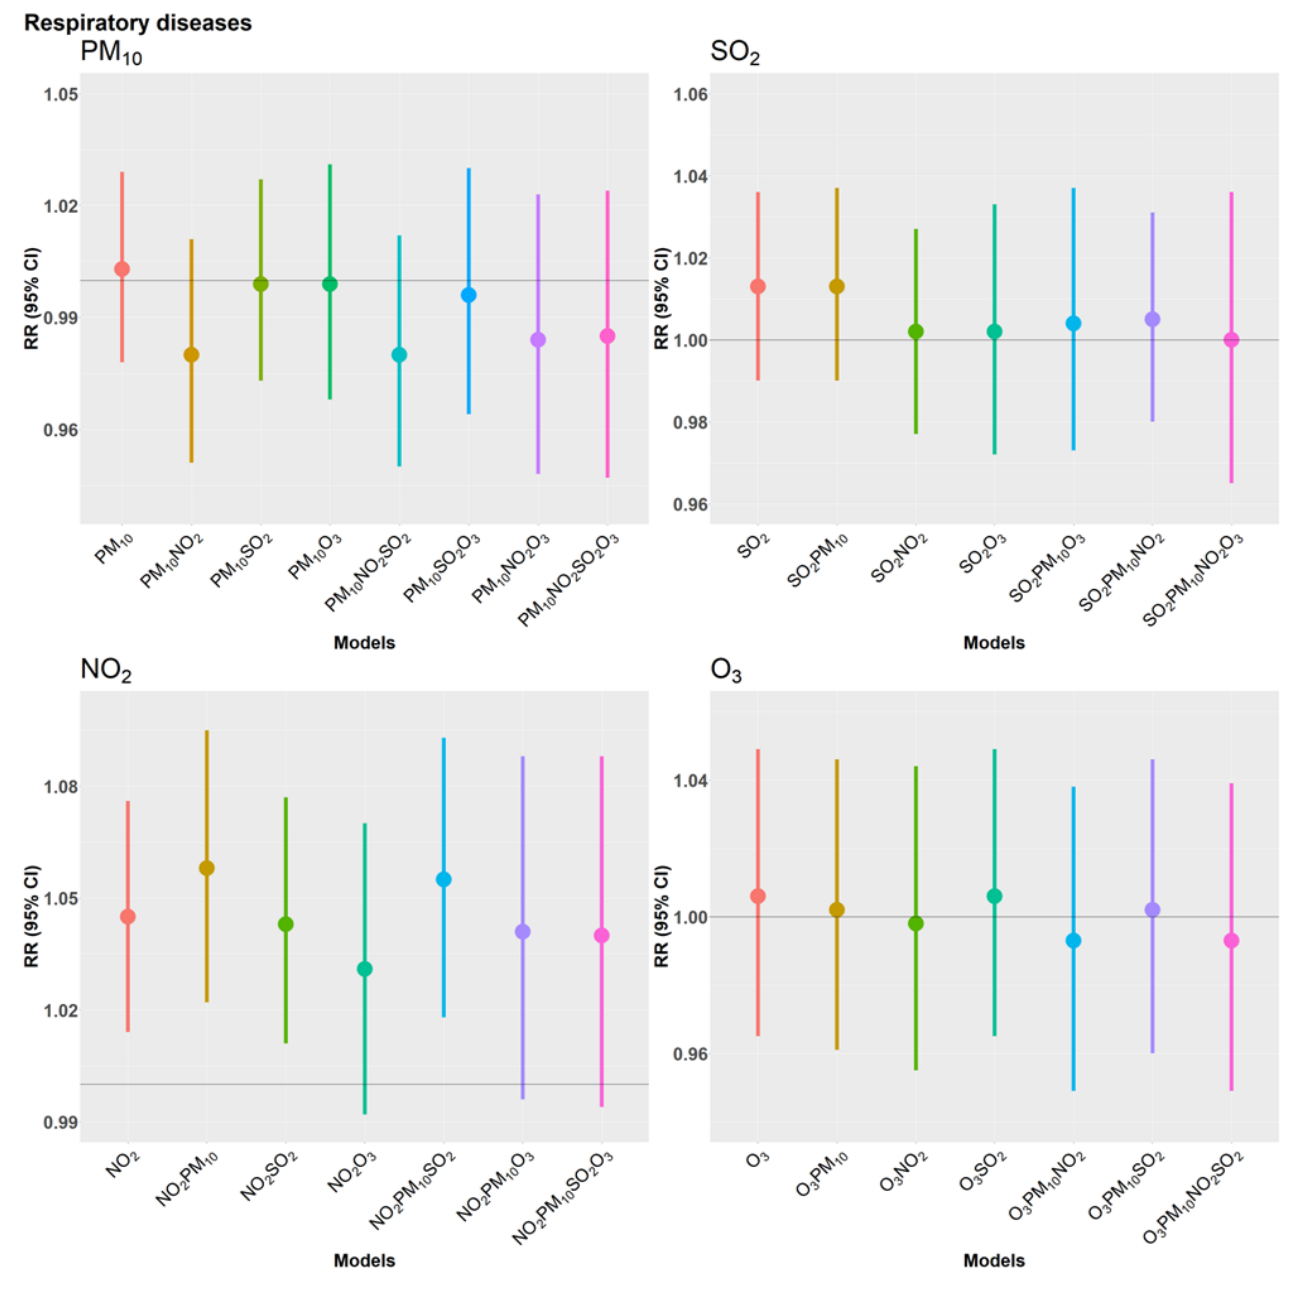
Figure 2. Overall relative risk estimated from Quasi-Poisson regression models of daily counts of respiratory disease deaths, adjusting for time trends and seasonal variation, day of the week, public holiday, temperature and relative humidity. Estimates are presented per IQR µ g/m 3 increase in the 2-day moving average (lag 0–1) of PM 10 , NO 2 , SO 2 and O 3 for the respective two-, three- and four-pollutant